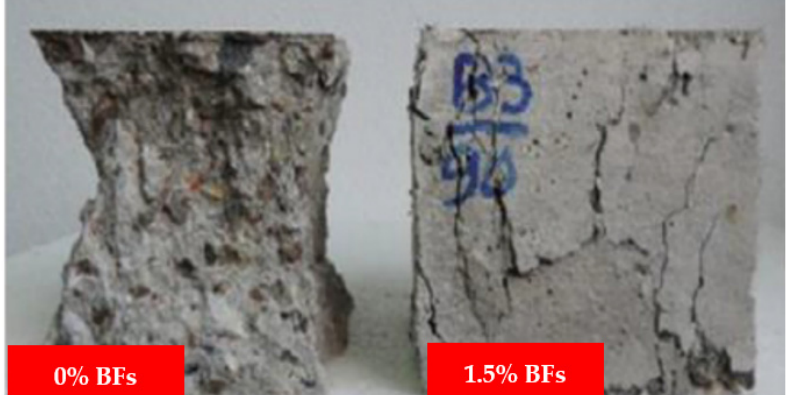
Figure 7. Compressive Failure Modes [50] with Elsevier permission.